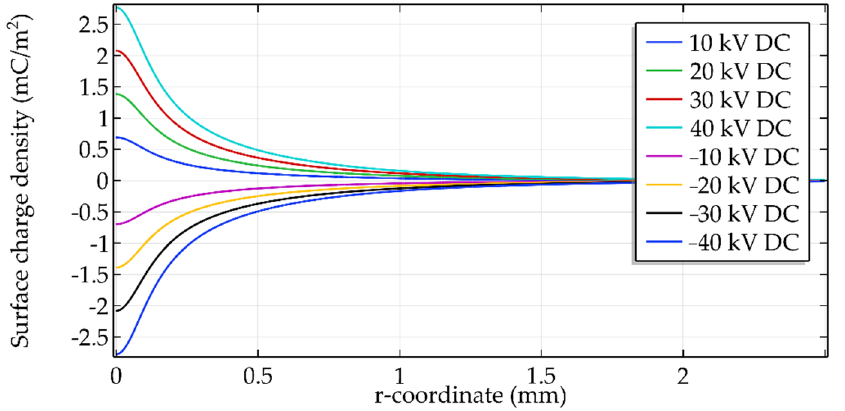
Figure 4. Surface charge density (mC/m 2 ) along the line ( 𝐼 ) (Figure 1) in the 2nd and 4th cases under applied DC voltage with different amplitudes.